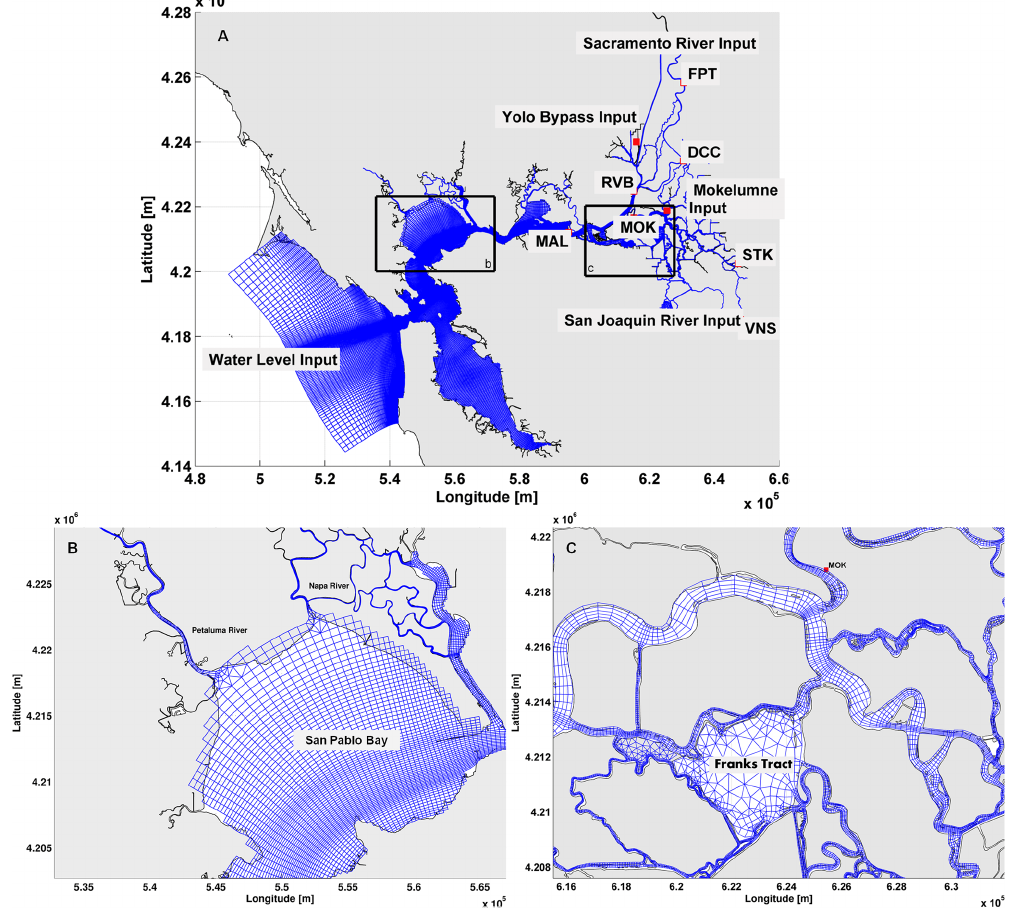
Figure 2. Numerical mesh for the D3D FM model. Red dots indicate the calibration stations (http://san-francisco-bay-delta-model. unesco-ihe.org/). Detailed box of the computational grid: (b) San Pablo Bay connecting to the Petaluma and Napa rivers, (c) delta chan- nels and Franks